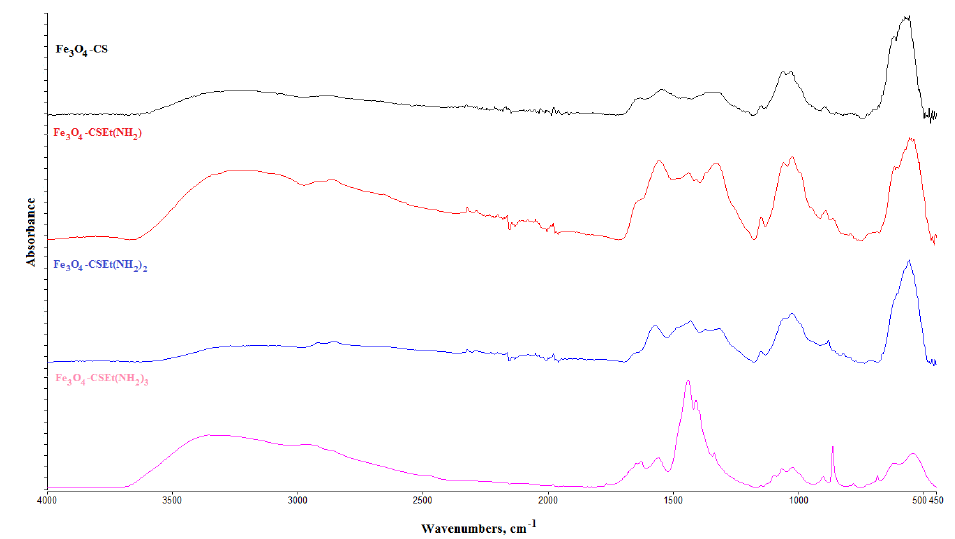
Figure 2. ATR-FT IR results for the prepared nanoparticles.